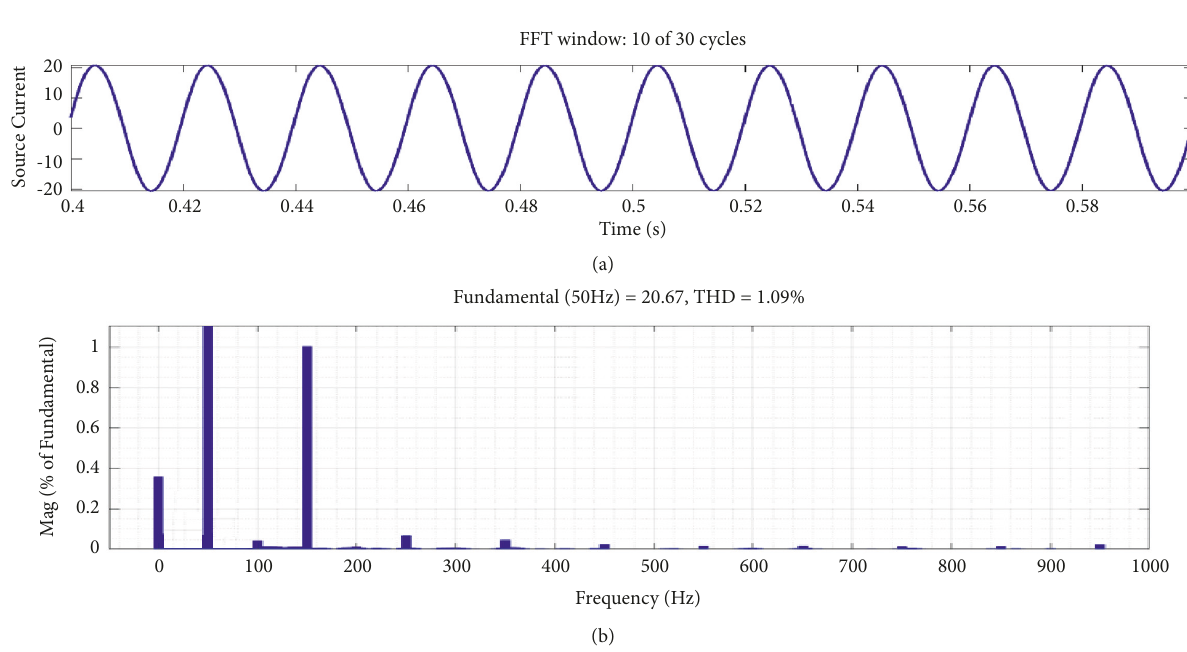
Figure 33: (a) Waveform of the source current with the implementation of fuzzy logic current controller FLCC (b) Frequency spectrum of the source current with the implementation of fuzzy logic current controller FLCC. Table 4: System Harmonic (THD %) contents comparison with and without HAPF based on FLCC. S.No System THD% (%) 1.